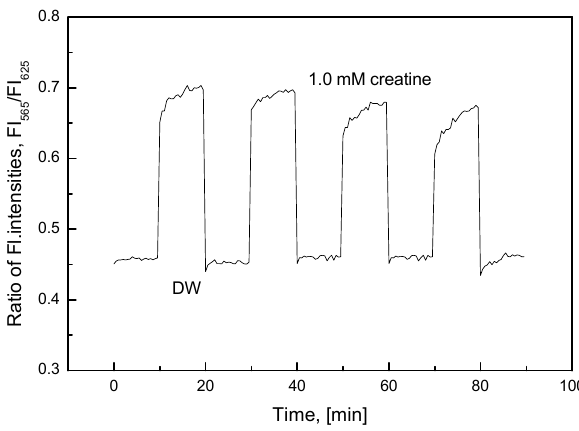
Figure 3. Reversibility of the creatine-sensing membrane in the presence of 1.0 mM creatine and distilled water (DW).